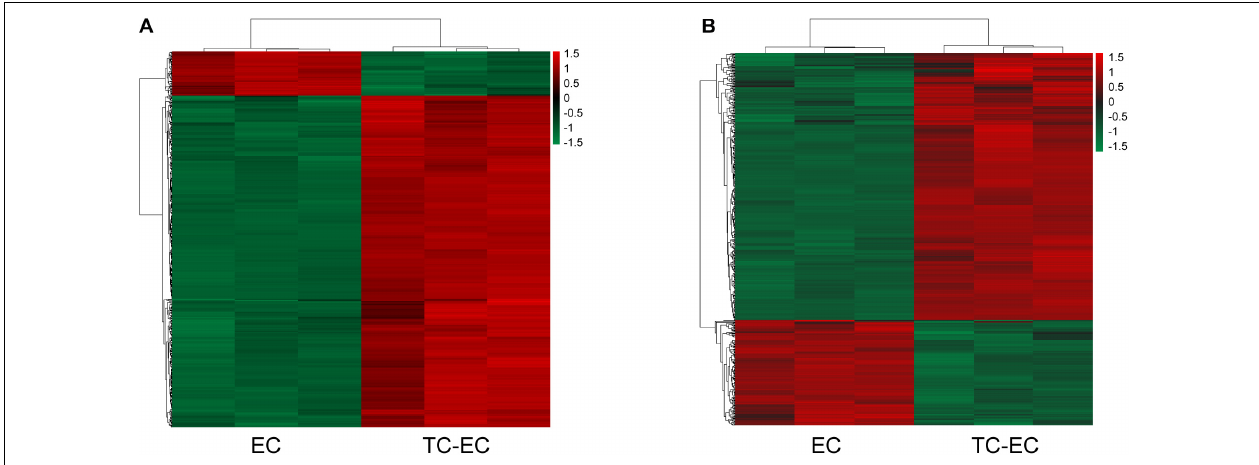
FIGURE 1 | Hierarchical clustering of aberrant expressed mRNAs (A) and lncRNAs (B) detected in the TC–EC model and EC alone. Every column represents a cell sample, and every row represents an mRNA or lncRNA probe. Red color indicates overexpression genes and green color indicates low-expression genes.